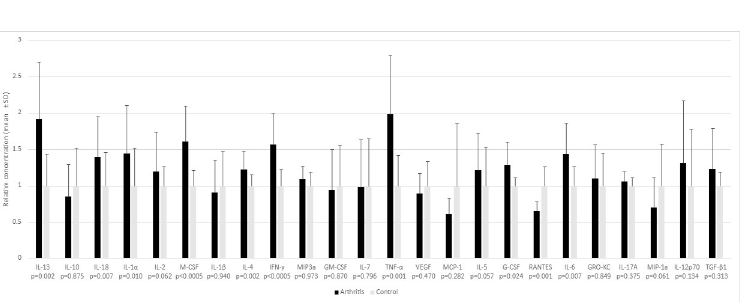
Fig 5. Histology of the right knees of the arthritic and control rats on day 8. Synovia as a sagittal view near the midline of the right arthritic knees for vehicle (A-B), dexamethasone (C-D), calcipotriol (E-F) and non-arthritic control (G-H) on day 8. The z-planes were chosen near the midline approaching from the medial side, preferentially patella not visible, and the femur completely visible in the section. The image areas are taken near the posterior part of the joints with 5x magnification on the left and 20x magnification on the right panels. F = femur (cartilage), T = tibia (cartilage), M = medial meniscus. Inflamed and proliferated synovia was observed in all knees injected with Zymosan (A-F). The average score of the synovial grading was smaller in the calcipotriol treated joint compared with vehicle. The dexamethasone and vehicle groups were similar. In non-arthritic control (G-H), the synovial membrane was clearly thinner. Representative images of hematoxylin-eosin staining have been chosen from each group. Extra images presenting the rats with the highest scores of synovial grading in each arthritic group are shown in Supporting Information (S3).